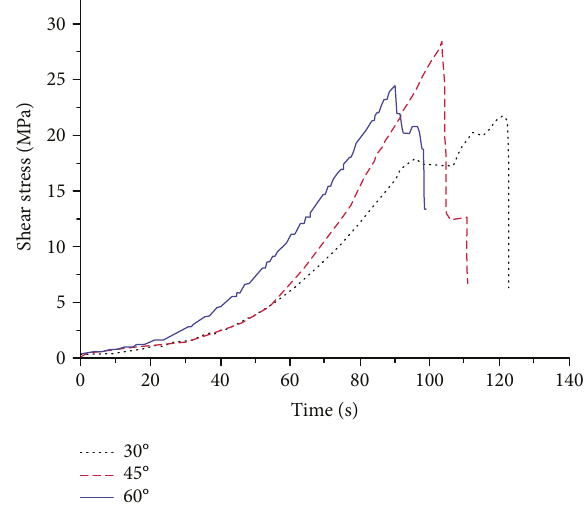
Figure 10: Shear stress-time curves at di ff erent laying angle of ore rock.